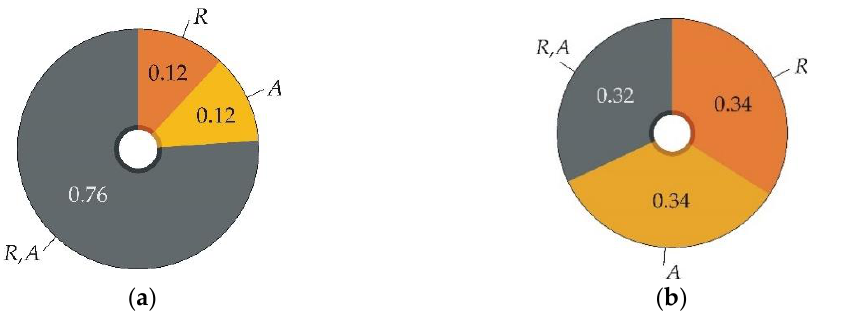
Figure 15. First- and second-order sensitivity indices from sensitivity analysis of P f using Z : ( a ) Sobol sensitivity indices; ( b ) Shannon’s entropy -based sensitivity indices.